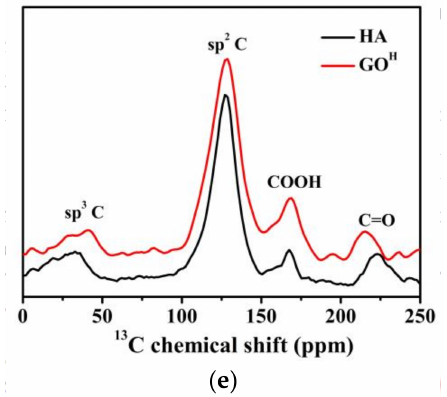
Figure 3. ( a ) Full-range XPS spectra of HA and GO H ; ( b ) C1s XPS spectra of GO H ; ( c ) C1s XPS spectra